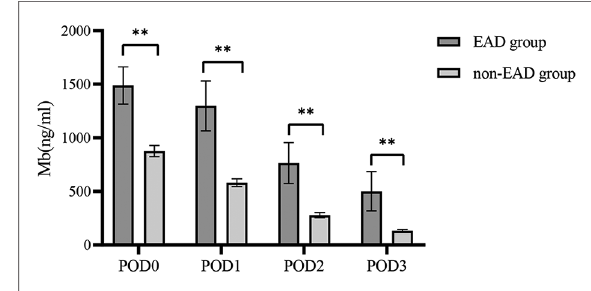
FIGURE 3 Distribution characteristics of myoglobin within 3 days between the EAD group and the non-EAD group after LT. The level of Mb decreased gradually after LT. Mb, myoglobin; EAD, early allograft dysfunction; POD, postoperative day; LT, liver transplantation. ** P <0.01 compared with the non-EAD